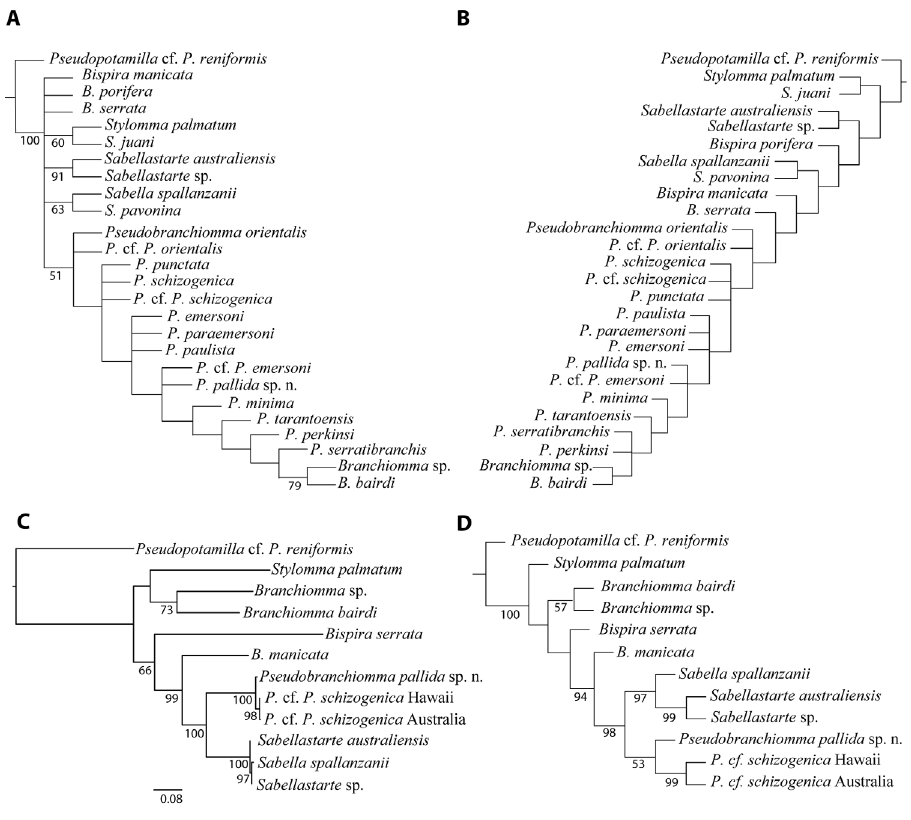
Figure 1. Phylogenetic hypothesis of Pseudobranchiomma and related taxa. A Strict consensus of six most-parsimonious trees after analyses of morphological data (33 characters) and 26 members of Sabel- lidae rooted with Pseudopotamilla . Jack-knife support values are given (>50) B Strict consensus of three most parsimonious tree after implementation of implied weighting (constant of concavity k = 7) C Tree after maximum likelihood analyses of mitochondrial and nuclear dataset. Bootstrap values on nodes if >50; scale: average of nucleotide substitutions per site D Single most-parsimonious tree after analyses of the combined morphological and molecular datasets (12 taxa and 2239 characters); Jack-knife support values are given